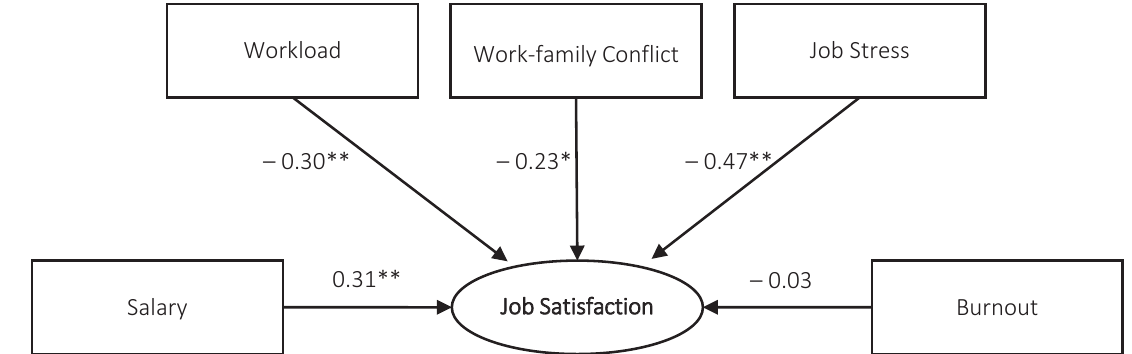
Figure 3. Results of multiple linear